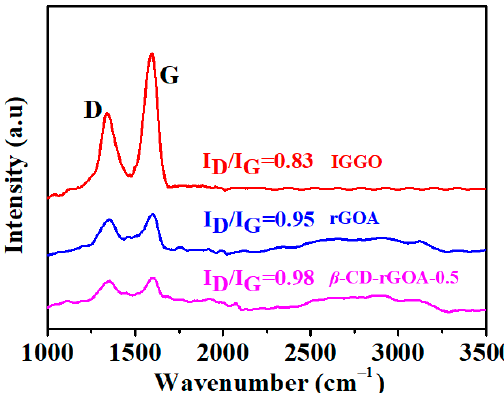
Figure 5. Raman spectra of IGGO, rGOA, and β -CD-rGOA-0.5. The broad peaks at 3441 cm − 1 are attributable to the O–H stretching vi-